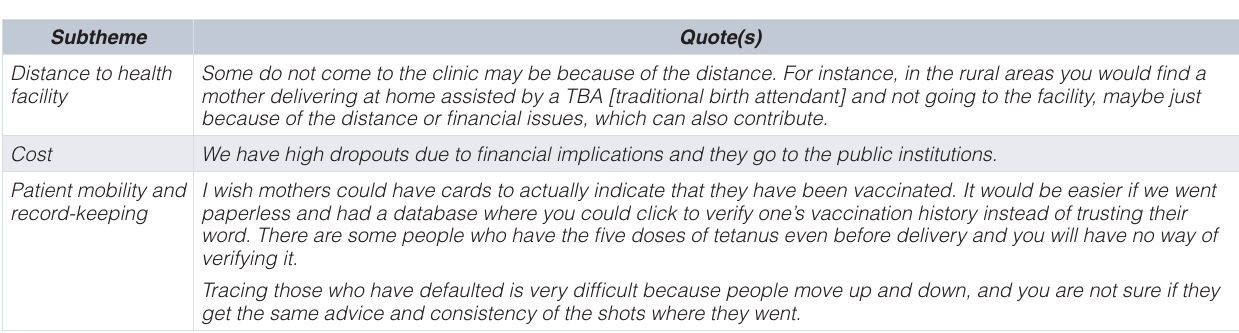
Table 6. Patient access